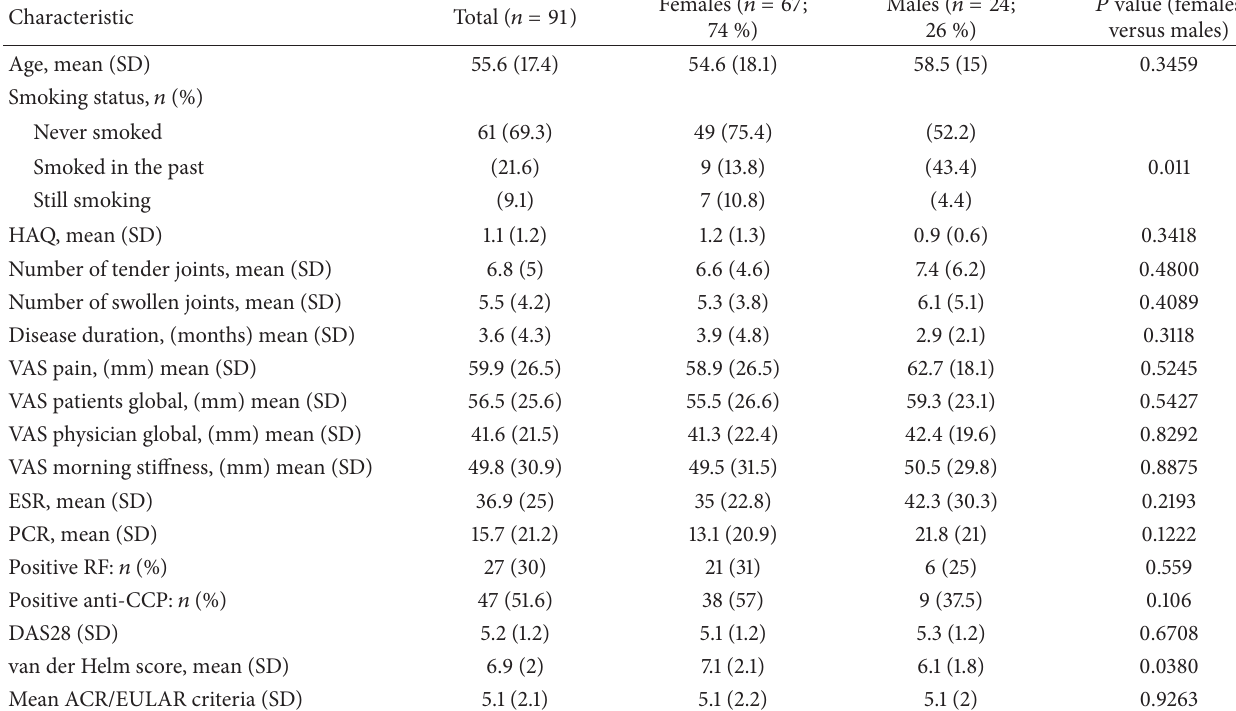
Table 1: General characteristic of total population and by sex.